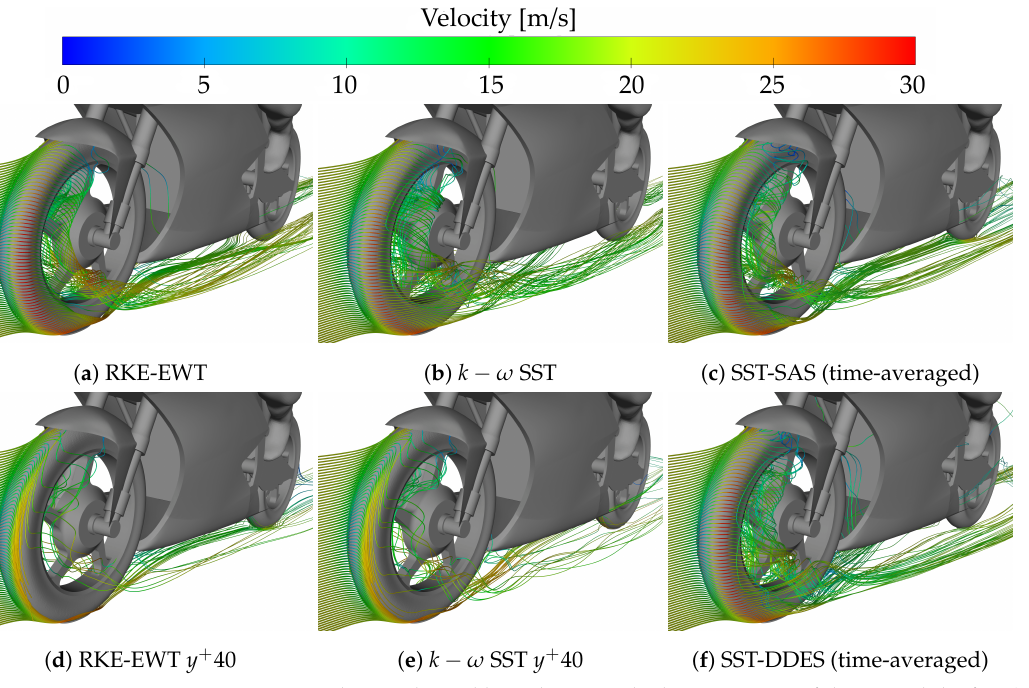
Figure 12. Streamlines coloured by velocity in the lower section of the motorbike for: ( a ) RKE-EWT, ( b ) k − ω SST, ( c ) SST-SAS (time-averaged), ( d ) RKE-EWT y + 40, ( e ) k − ω SST y + 40, ( f ) SST-DDES